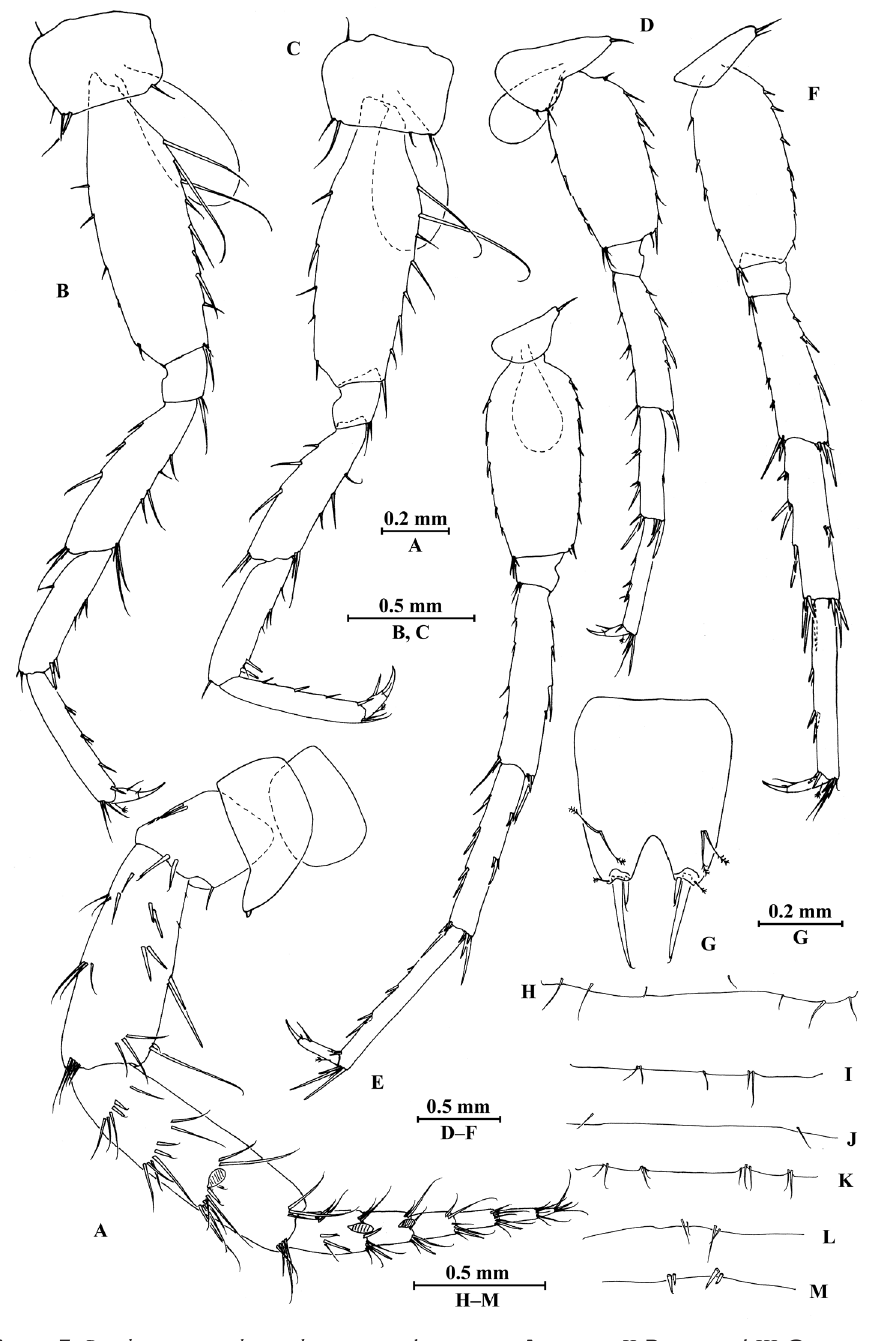
Figure 7. Pseudocrangonyx elegantulus sp. n., male paratype. A antenna II B pereopod III C pereopod IV D pereopod V E pereopod VI F pereopod VII G telson H pereonite VII (dorsal view) I–K pleonites (dorsal view) L, M urosomites I, II (dorsal